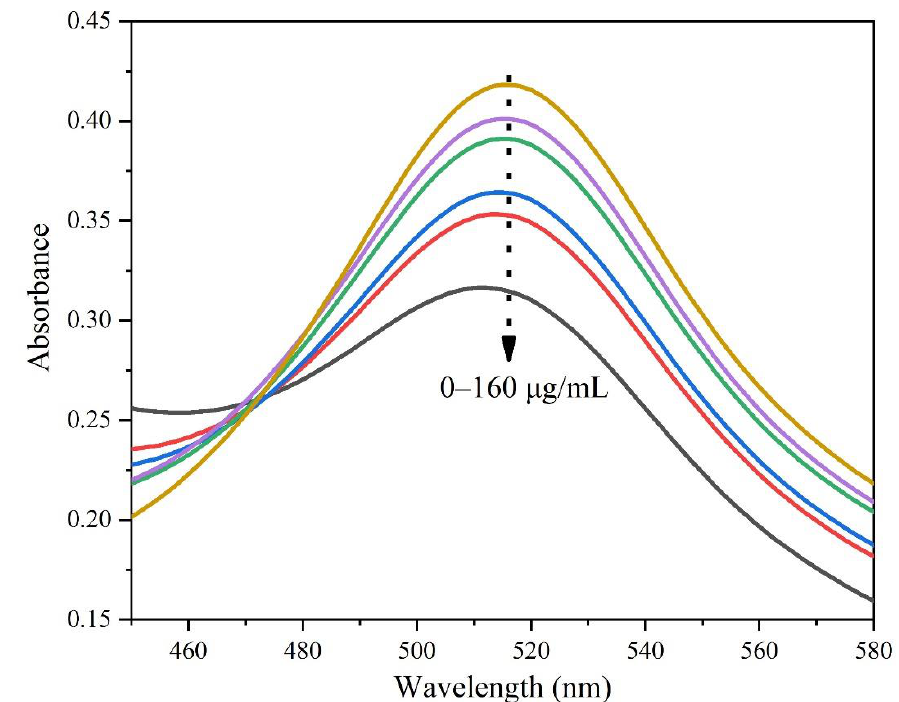
Figure 5. Absorbance titration spectra of 1,1-diphenyl-2-picrylhydrazyl (DPPH) upon gradual addition of L-CDs from 0 to 160 μg/mL.